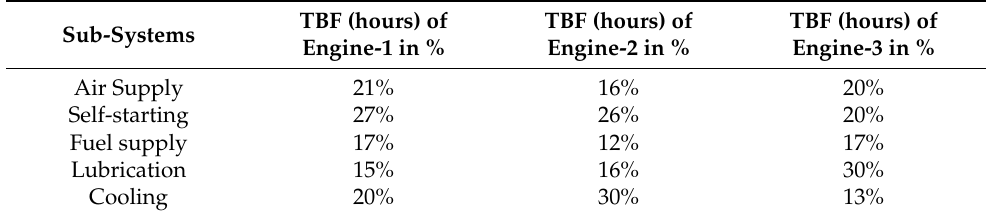
Table 2. Data of occurrence of failures for three engines.